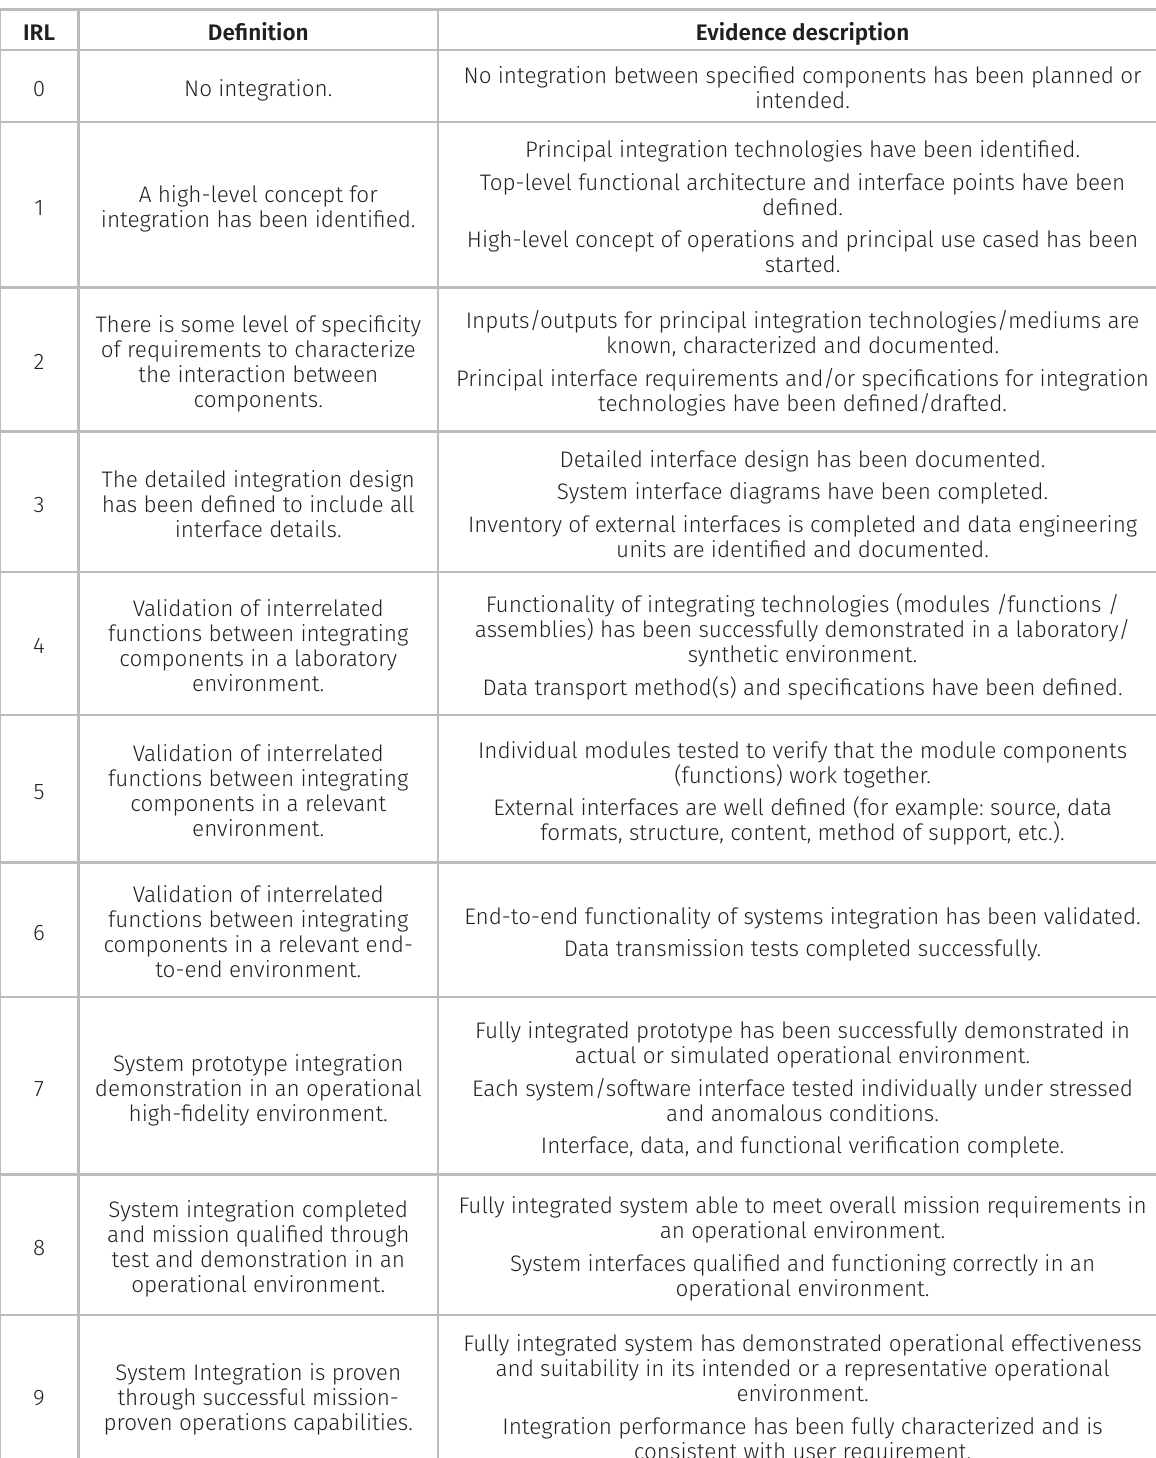
Table I. Integration Readiness Levels scale (Austin & York